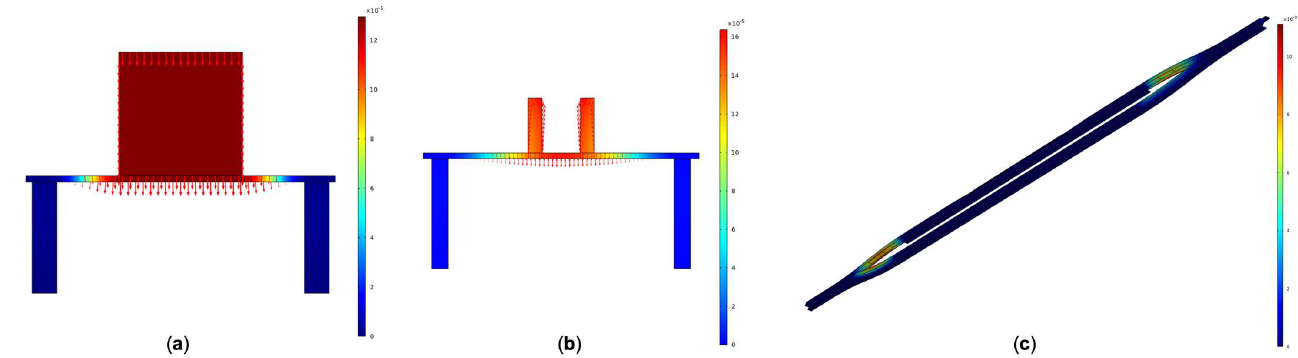
Figure 10. The schematic diagram of the mechanical analysis of the device: ( a ) the entry position of the central coupling region; ( b ) the slot waveguide; and ( c ) the 3D device structure.